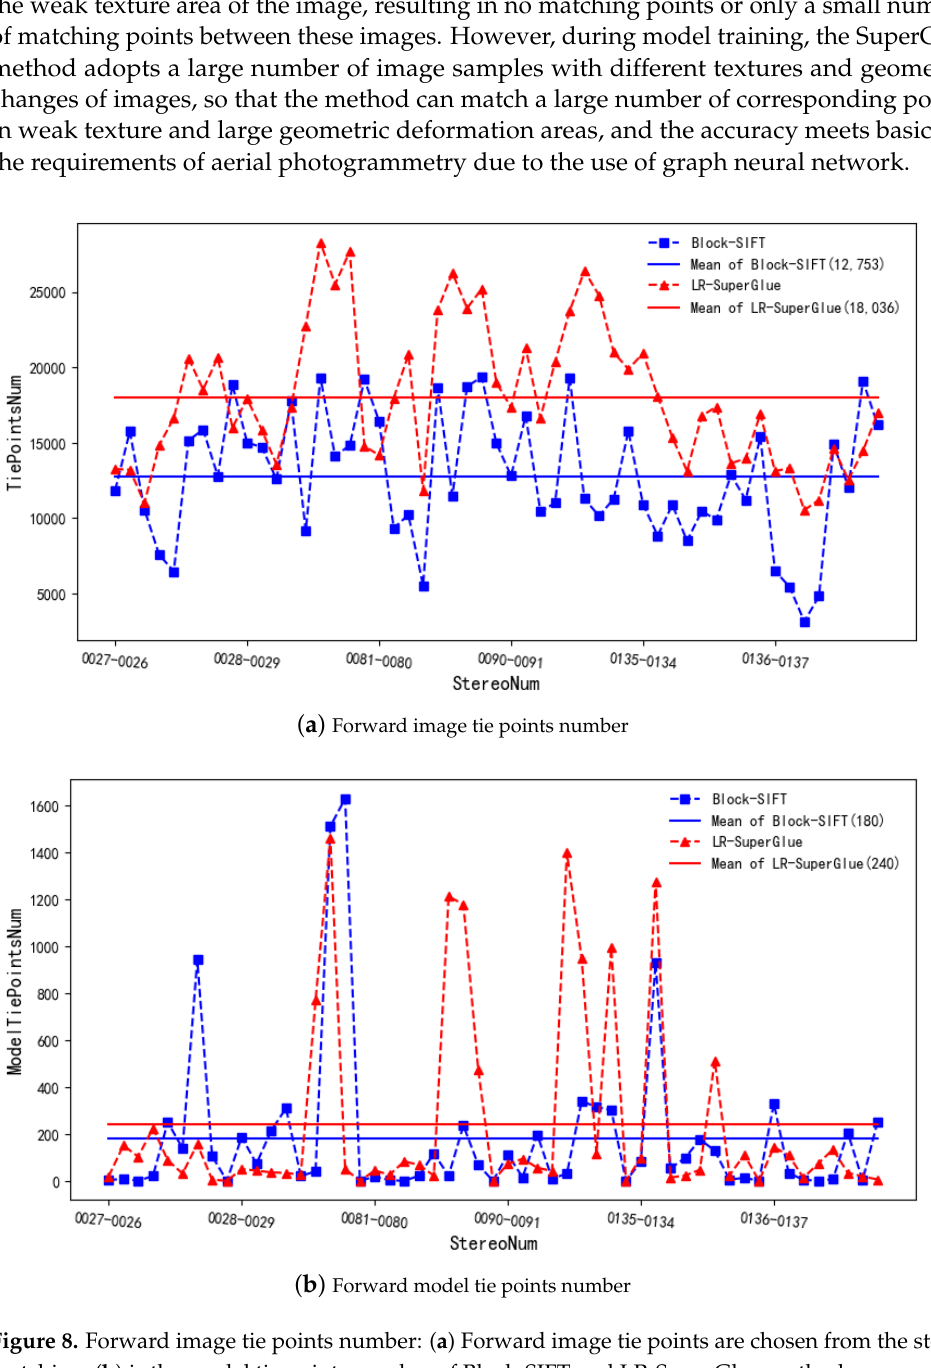
Figure 8. Forward image tie points number: ( a ) Forward image tie points are chosen from the stereo matching; ( b ) is the model tie points number of Block-SIFT and LR-SuperGlue